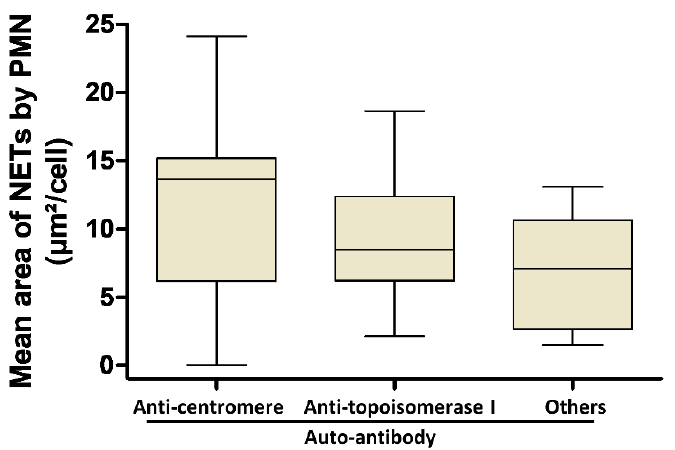
Figure 3. NETosis phenomenon occurring in SSc cannot be explained by the specificity of autoantibody. PMN from SSc patients were stimulated in autologous conditions. Patients were grouped according to the AAb specificity (anti-centromere AAb (n = 17), anti-topoisomerase I AAb (n = 8) or other AAb (n = 9)). All stimulations were performed in duplicate. The mean area of NETs released by PMN is represented by a “box and whiskers” plot for each condition tested. Boxes show the 25–75th percentiles, lines show the median value, and whiskers show the range of the mean area of NETs released by PMN.